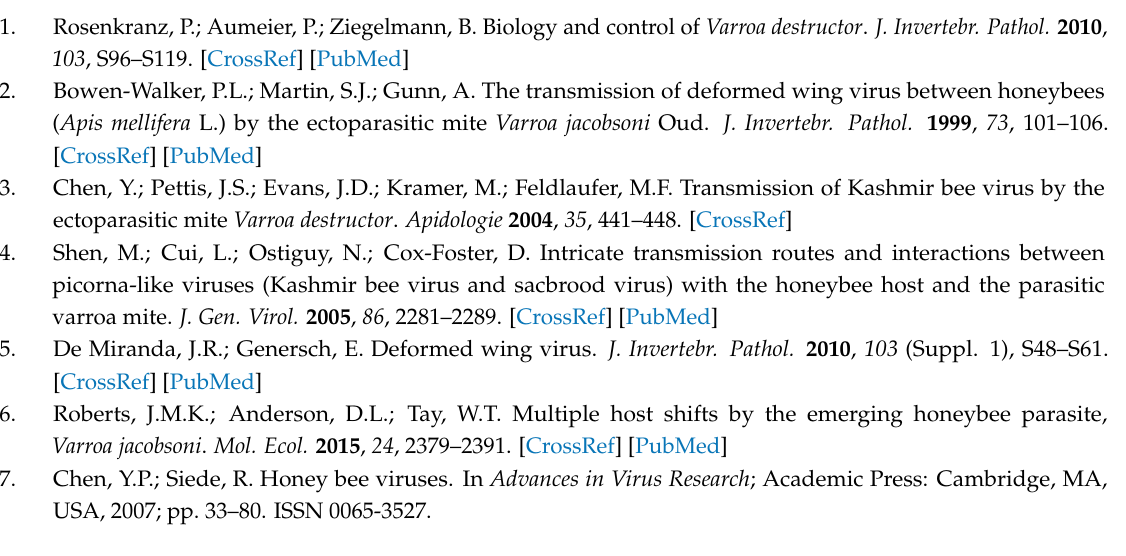
Figure S1: title, Table S1: Table S1. Primers used for validation and quantitation of Varroa orthomyxovirus-1 (VOV-1). Table S2. Primers used for validation and quantitation of Varroa destructor virus-4 (VDV-4). Table S3. Complete VOV-1 nucleotide sequences. Table S4. Nucleotide sequence of